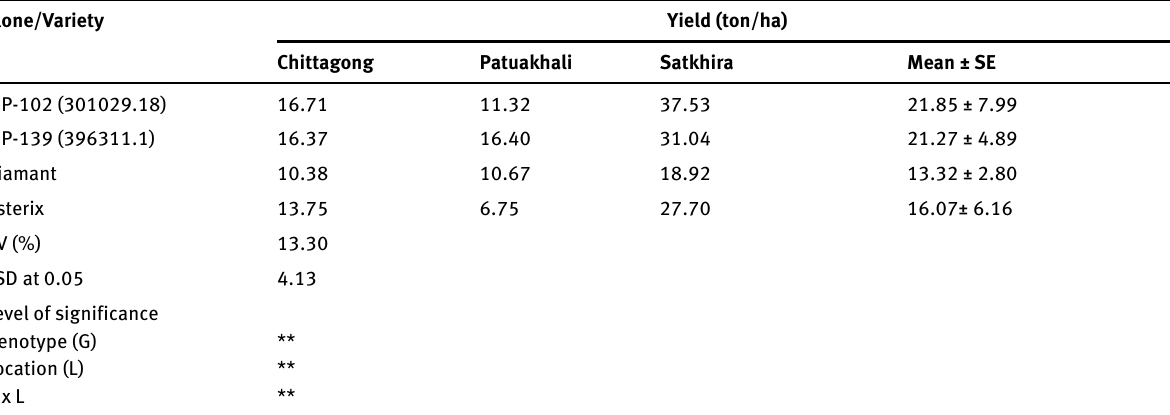
Figure 8: Mean senescence score of 2 CIP promising clones at 60 to 88 days during 2014-15 crop seasons Table 4: Tuber yield of 2 CIP promising potato clones and in check varieties at 3 saline locations in Bangladesh at harvest (90 DAP) during 2014-15 crop season